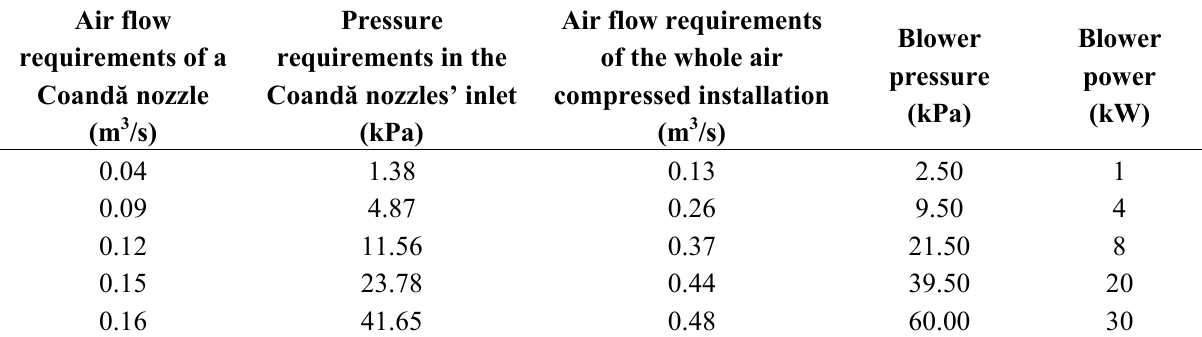
Table 2. Air flow, pressure and power requirements of the air compressed installation.